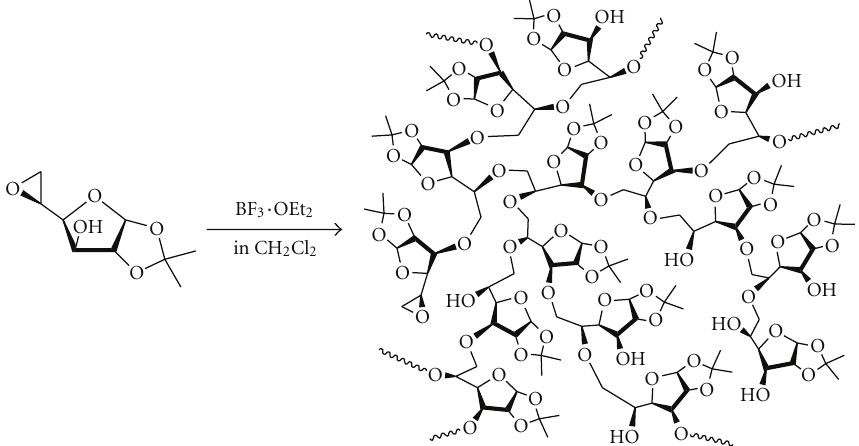
Scheme 8: Synthesis of hyperbranched